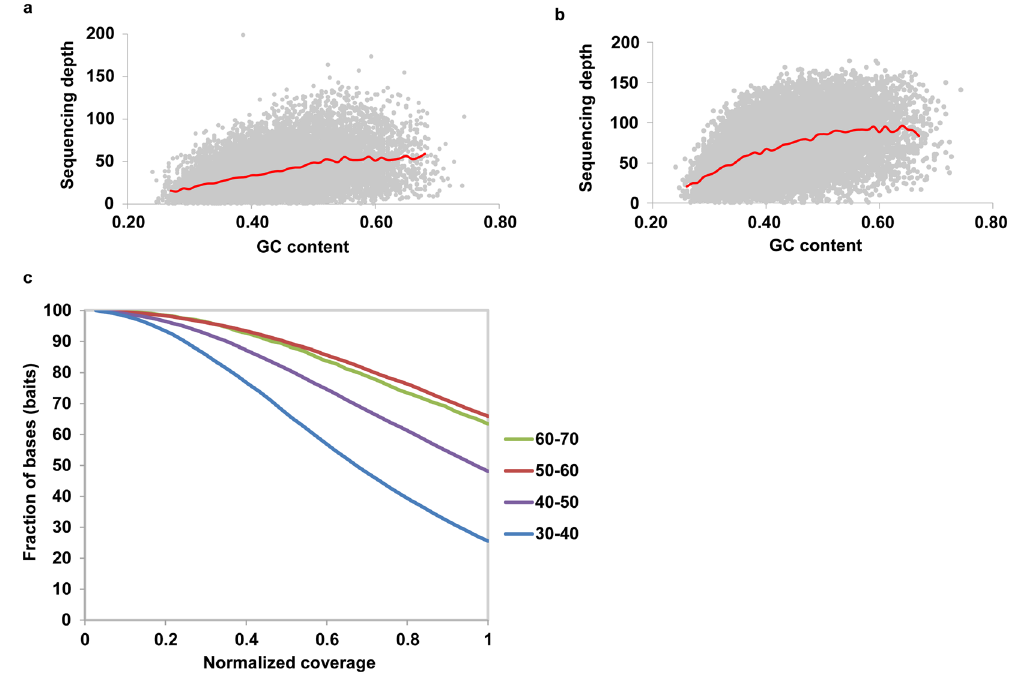
Figure 5. The relationship between GC content and sequencing depths. ( a ) Average depth of target SNP was 37. ( b ) Average depth of target SNP was 69. The red lines indicated mean depth. ( c ) Normalized coverage distribution plots in four different GC% categories.